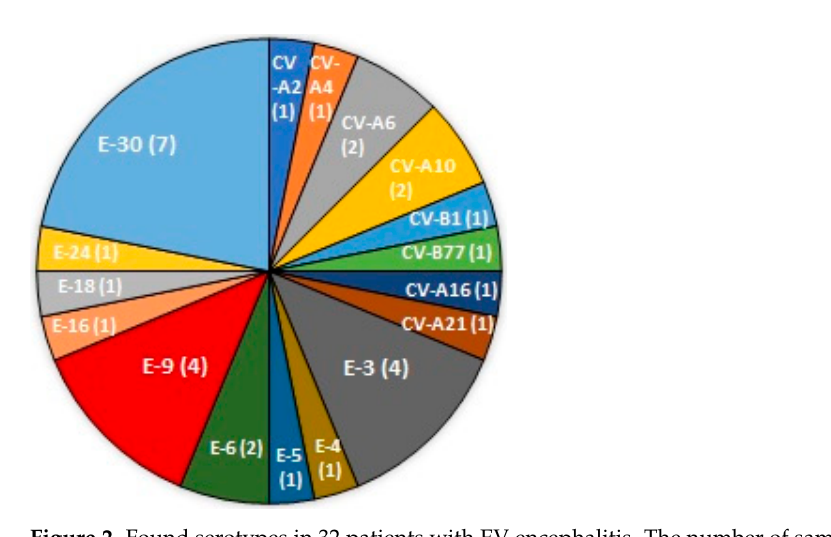
Figure 1. Cause of encephalitis from 2013 to 2018: ( A ) the number of patients with and without pathogen detected by year; ( B ) summary of CSF finding by year.